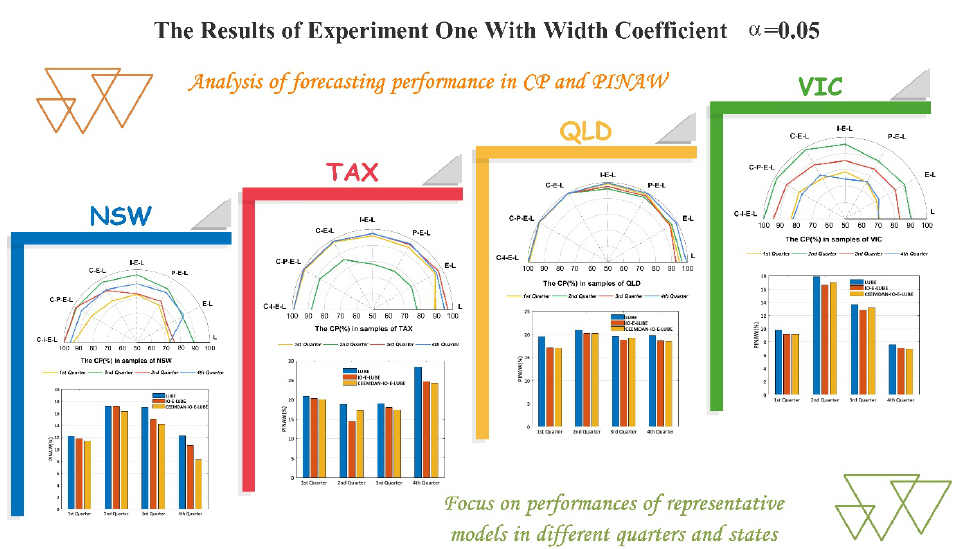
Figure 5. Performance of different samples with the width coefficient 0.05.